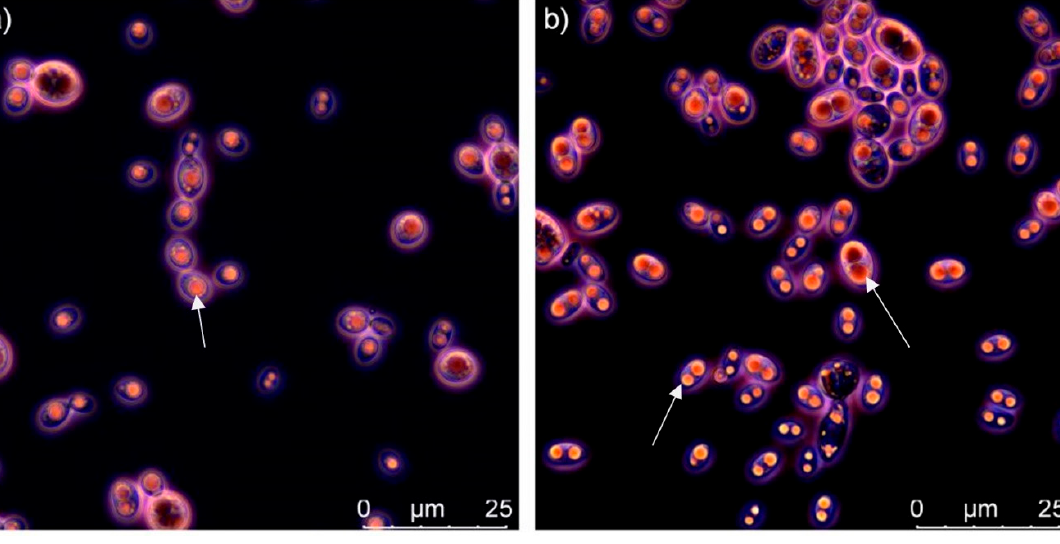
Figure 2. Microscopy images (false coloring) of C. infirmominiatum CCY 17 ‐ 18 ‐ 4 ( a ), and C. macerans CCY 10 ‐ 1 ‐ 2 ( b ) grown in medium with C/N ratio 100:1 (white arrows indicate lipid droplets).